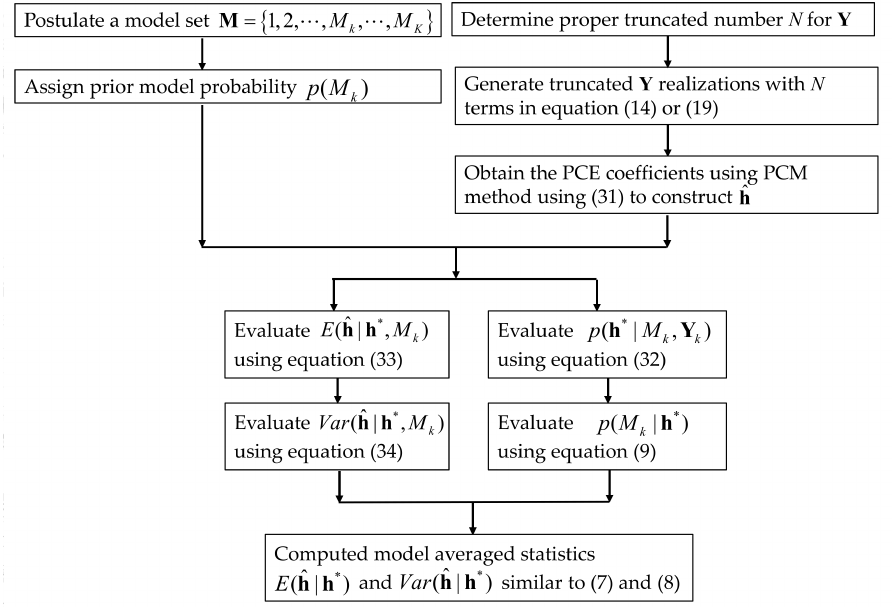
Figure 2. Flowchart for probabilistic collocation method (PCM)-based multi-model